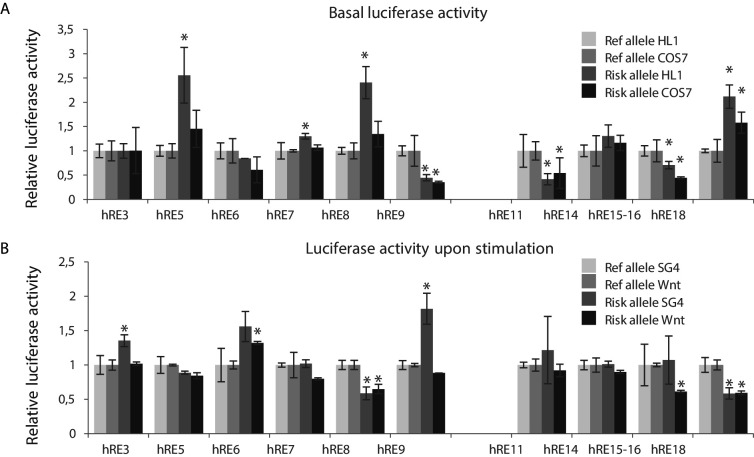
Identification of functional variants affecting RE candidate activity within human VR1 and VR2.(A) Basal luciferase activity of the reference and alternative alleles for each RE candidate in HL-1 and COS-7 cells. Luciferase activities were normalized to the activity of the reference allele for each fragment, in both HL-1 and COS-7 cells. (B) Relative luciferase activity of the reference and alternative alleles for each RE candidate upon stimulation with Smad- and Gata4 factors (SG4) and Tcf+LiCl factors (Wnt) in COS-7 cells. SG4/Wnt activity of the alternative alleles were normalized to the respective activity of the reference allele for each RE candidate. Transfections were performed in duplicates and replicated twice. Error bars represent standard deviations. *: p<0.05 (Student’s t-test).